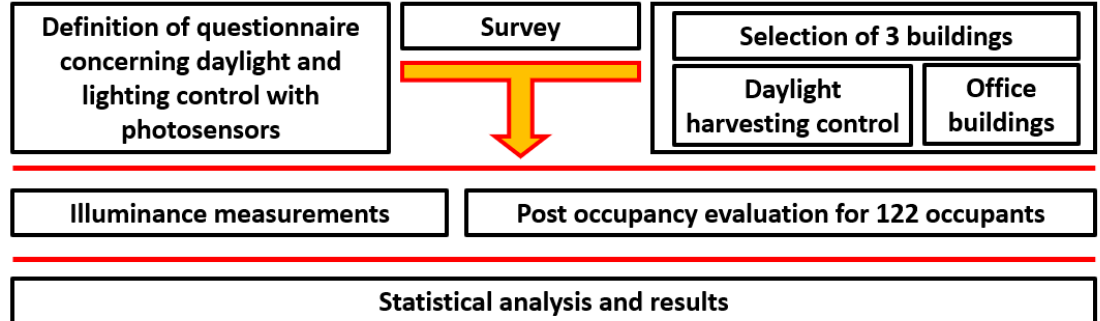
Figure 1. Diagram of the post-occupancy evaluation method.